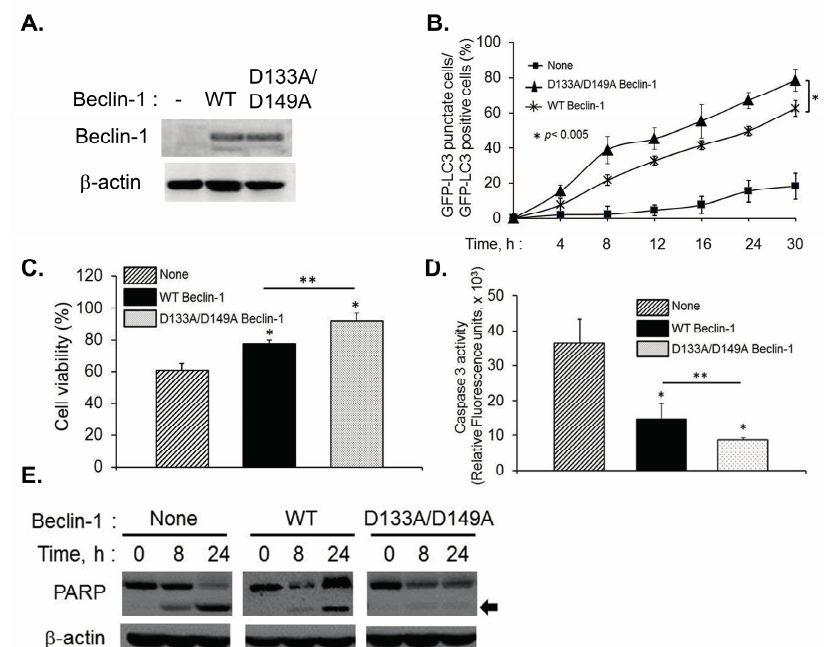
Figure 6. Effect of caspase-resistant Beclin-1 on autophagy and apoptosis in Beclin-1 knock down cells. ( A ) Endogenous Beclin-1 levels were knocked down using siRNA that does not target Beclin-1 cDNA and expression of RNAi-resistant Flag-Beclin-1 (WT) or RNAi